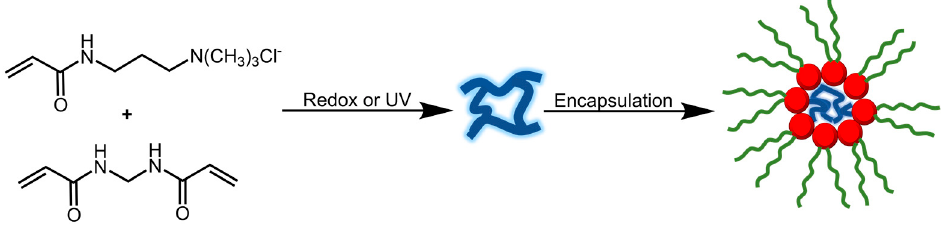
Figure 10. Representation of a photochemical reaction model for obtaining nanogels catalyzed by photoinitiators in the presence of crosslinking agents.